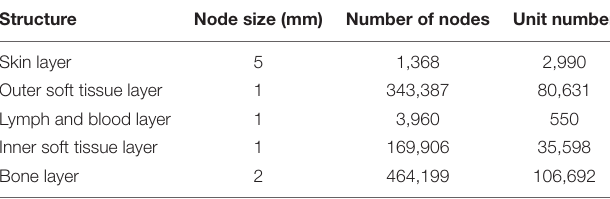
TABLE 2 | Unit number and node number in each layer of the upper arm model. Structure